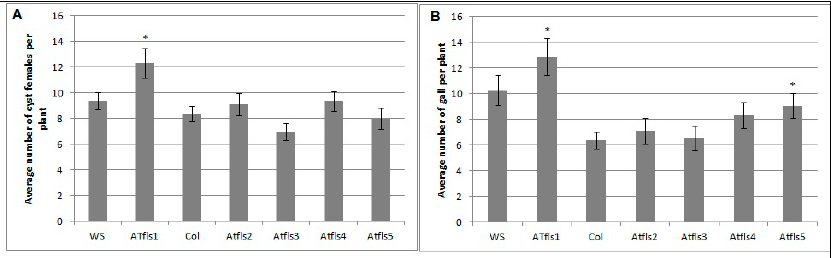
Atfls2 , Atfls3 , Atfls4 , and Atfls5 knock-outs, two wild-type Arabidopsis plants; Col-0 and WS, were planted sterilized J2 of either H. schachtii or M. incognita . Three weeks after inoculation, the number of cyst female nematodes (for sugar beet cyst nematode) per root system or galls (for southern root-knot nematode) were counted. Data are presented as means ± standard errors. Mean values significantly di ff erent from the wild type ecotype as determined by t test ( p < 0.05). Similar results were obtained from a second, independent biological